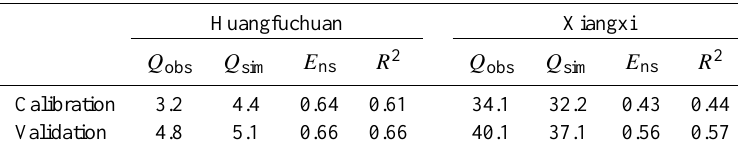
Table 3. Goodness of fit for SWAT simulations in River Xiangxi and River Huangfuchuan ( Q obs and Q sim are observed and simulated mean monthly discharge in m 3 s − 1 ).